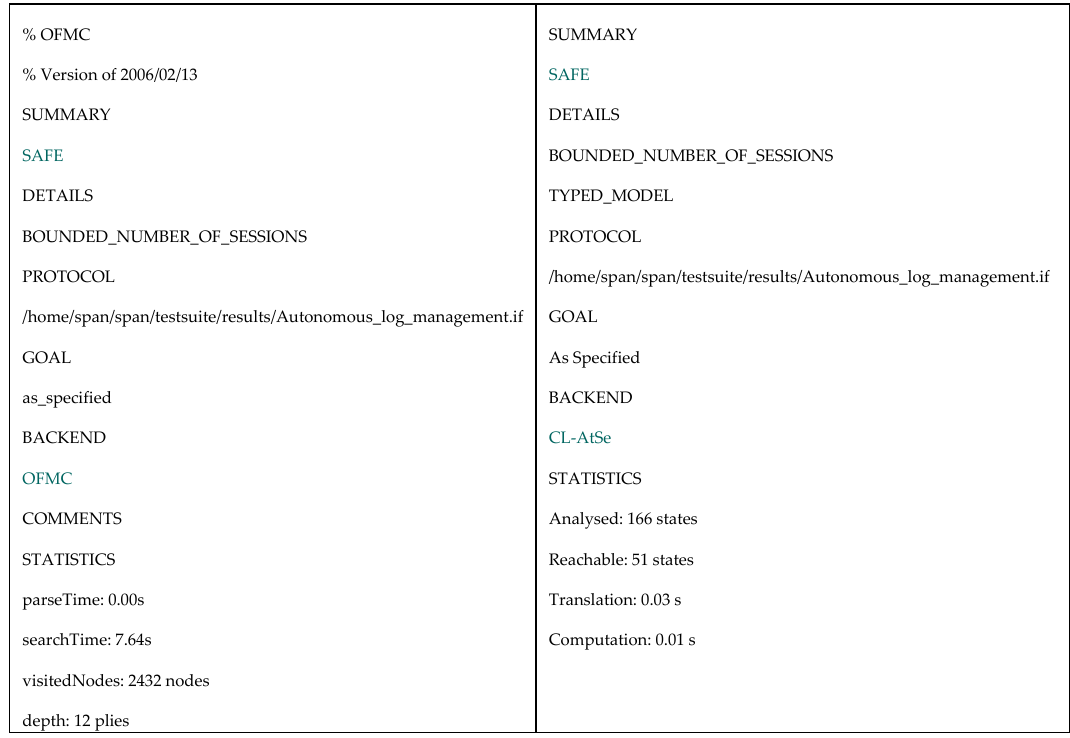
Figure 8. Verification results using OFMC and CL-AtSe backends.